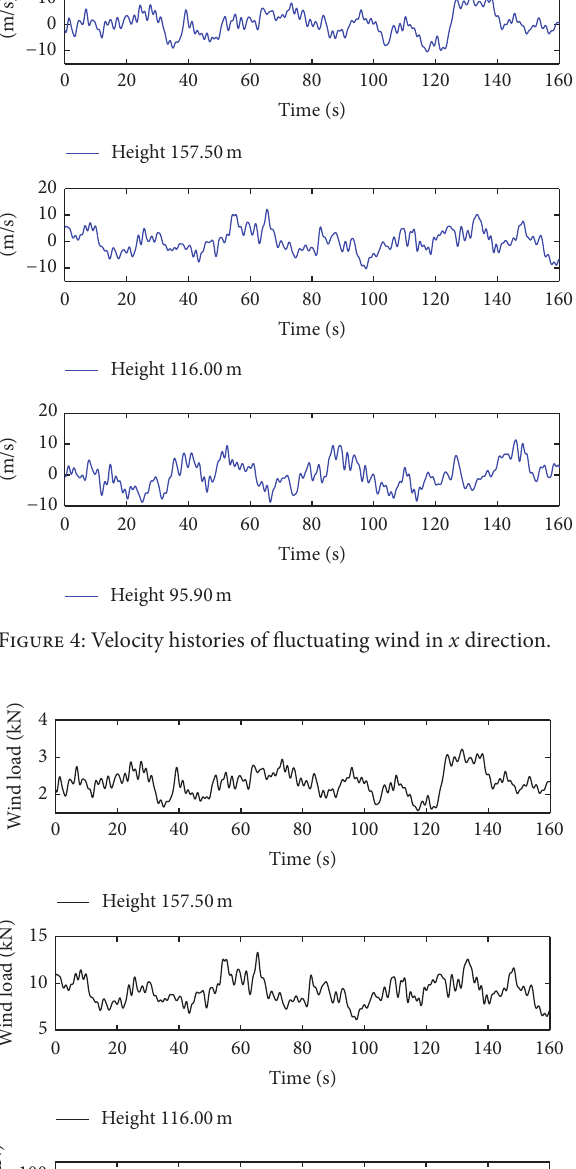
the first item in the square bracket is the number of dampers in the equivalent horizontal direction, and the second item is the diameter of the rotor in each damper. The vertical thickness of the rotor can be smaller so as to save space, and the value is set as 0.1 m in this study. The mass of each multiple cardan gyroscope damper is 100 kg.